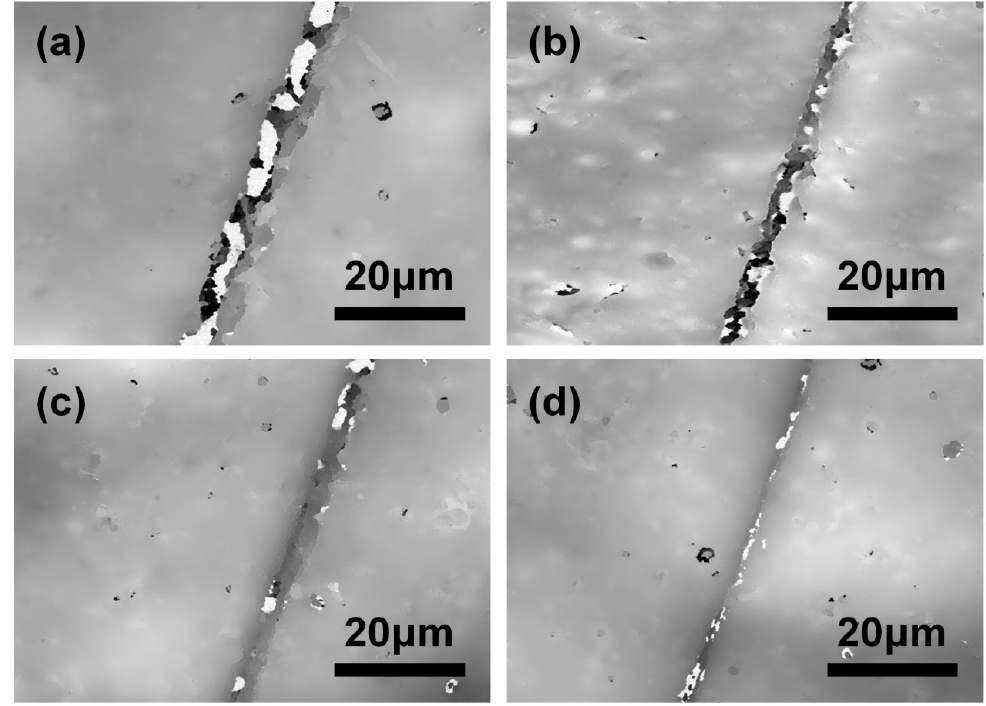
Figure 13. TCCM images of scratched regions with various contents of dual-component microcapsules: ( a ) 5 wt %; ( b ) 10 wt %; ( c )15 wt % and ( d ) 20 wt %.